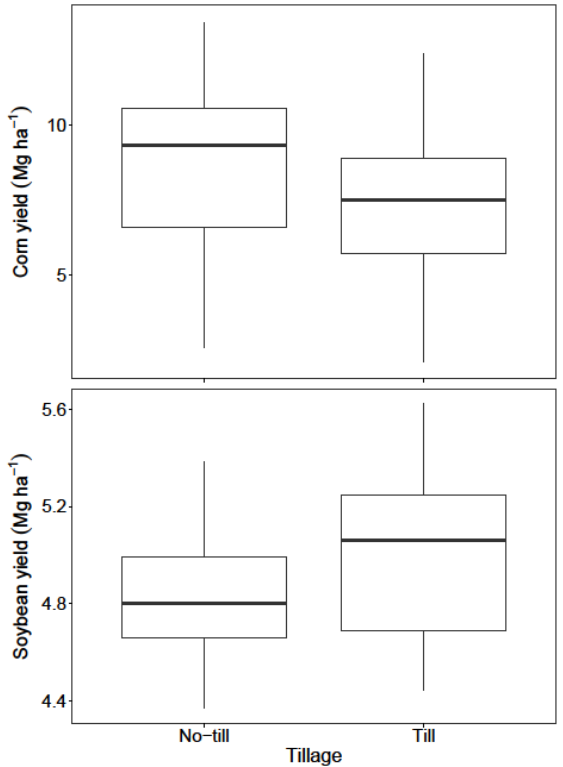
Figure 1. Corn and soybean grain yields in organic rotational no-till systems (No-till) and tillage-based organic systems (Till) at the Agricultural Research Center, Beltsville, Maryland. Corn data span the 2008–2016 growing seasons (2008–2010 with monoculture hairy vetch cover crop; 2011–2016 with cereal rye/hairy vetch cover crop mixtures); soybean data are from the 2015–2016 growing seasons. Corn yields were significantly greater in no-till compared with till ( F 1,50 = 6.45, p = 0.01); soybean yields did not differ between systems. Box plots represent the median (horizontal line), interquartile range (box) and the maximum and minimum values (end of each vertical line).